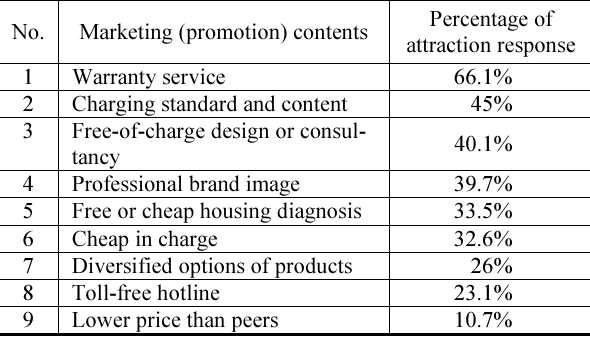
Table 2. Attraction of Marketing Tools to